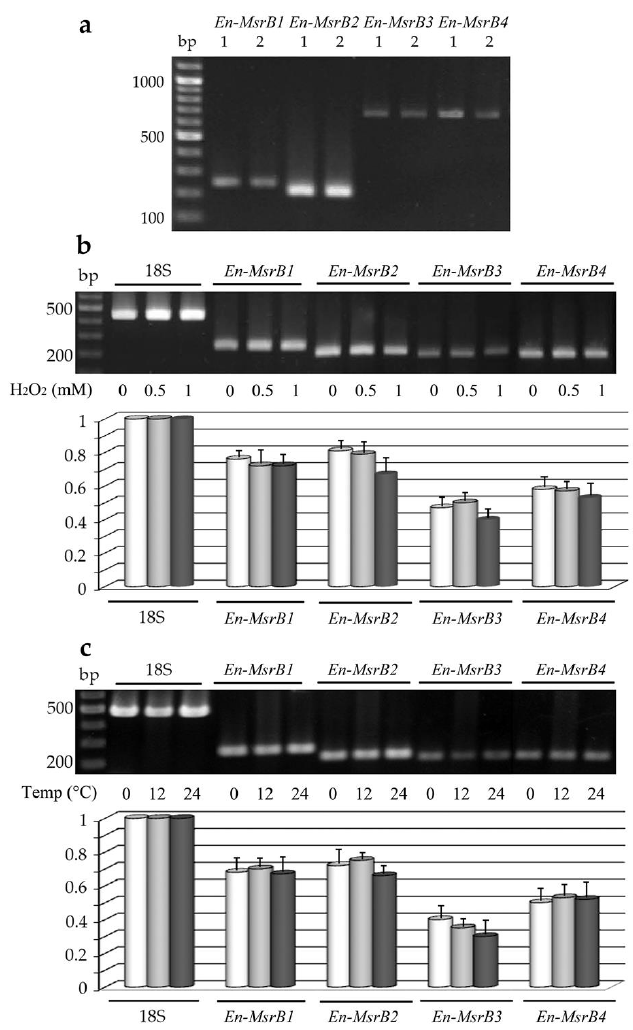
Figure 4. Expression of the E. nobilii En-MsrB genes. ( A ) Gel electrophoresis of PCR products obtained by amplifying DNA (lanes 1) or cDNA (lanes 2) preparations with En-MsrB gene-specific primers. ( B ) Electrophoretic separation (upper panel) and relative transcript abundance (lower panel) of sqRT-PCR products obtained from cells treated for 30 min with increasing concentrations of H 2 O 2 . ( C ) Electrophoretic separation (upper panel) and relative transcript abundance (lower panel) of sqRT-PCR products obtained from cells exposed for 30 min at increasing temperatures. In both ( B) and ( C) , values were calculated taking the 18S-rRNA PCR fragments as value 1 and represent the means (± SD) of three independent experiments.